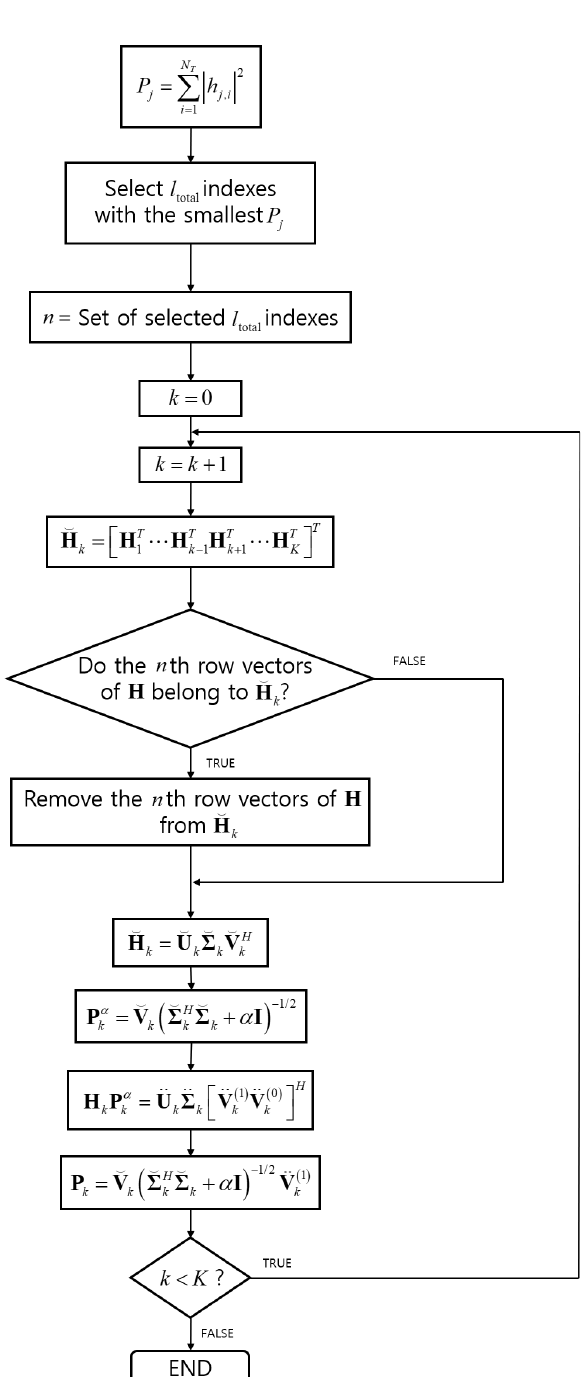
Figure 2. Flowchart of the proposed